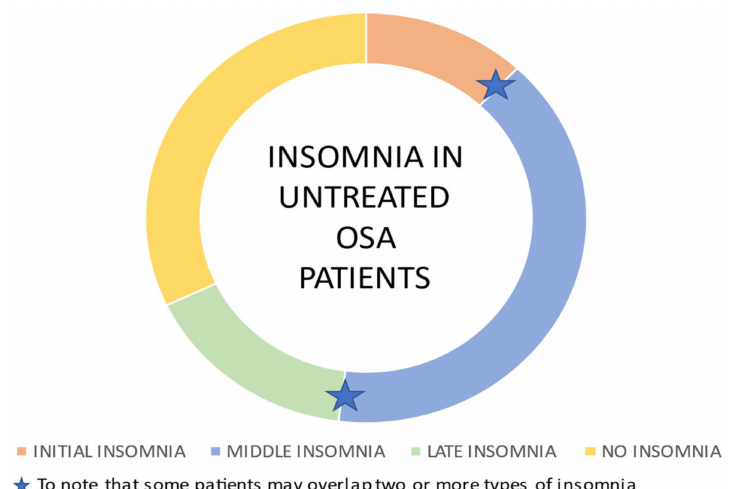
Figure 3. Insomnia subtypes in untreated OSA patients. The majority of untreated OSA patients is affected by middle insomnia consistent with OSA fragmentation induced sleep, while one-third of these patients do not experience insomnia. Some patients refer to difficulty in falling asleep (initial insomnia) or early morning awakenings (late insomnia). Some patients may overlap two or more types of insomnia